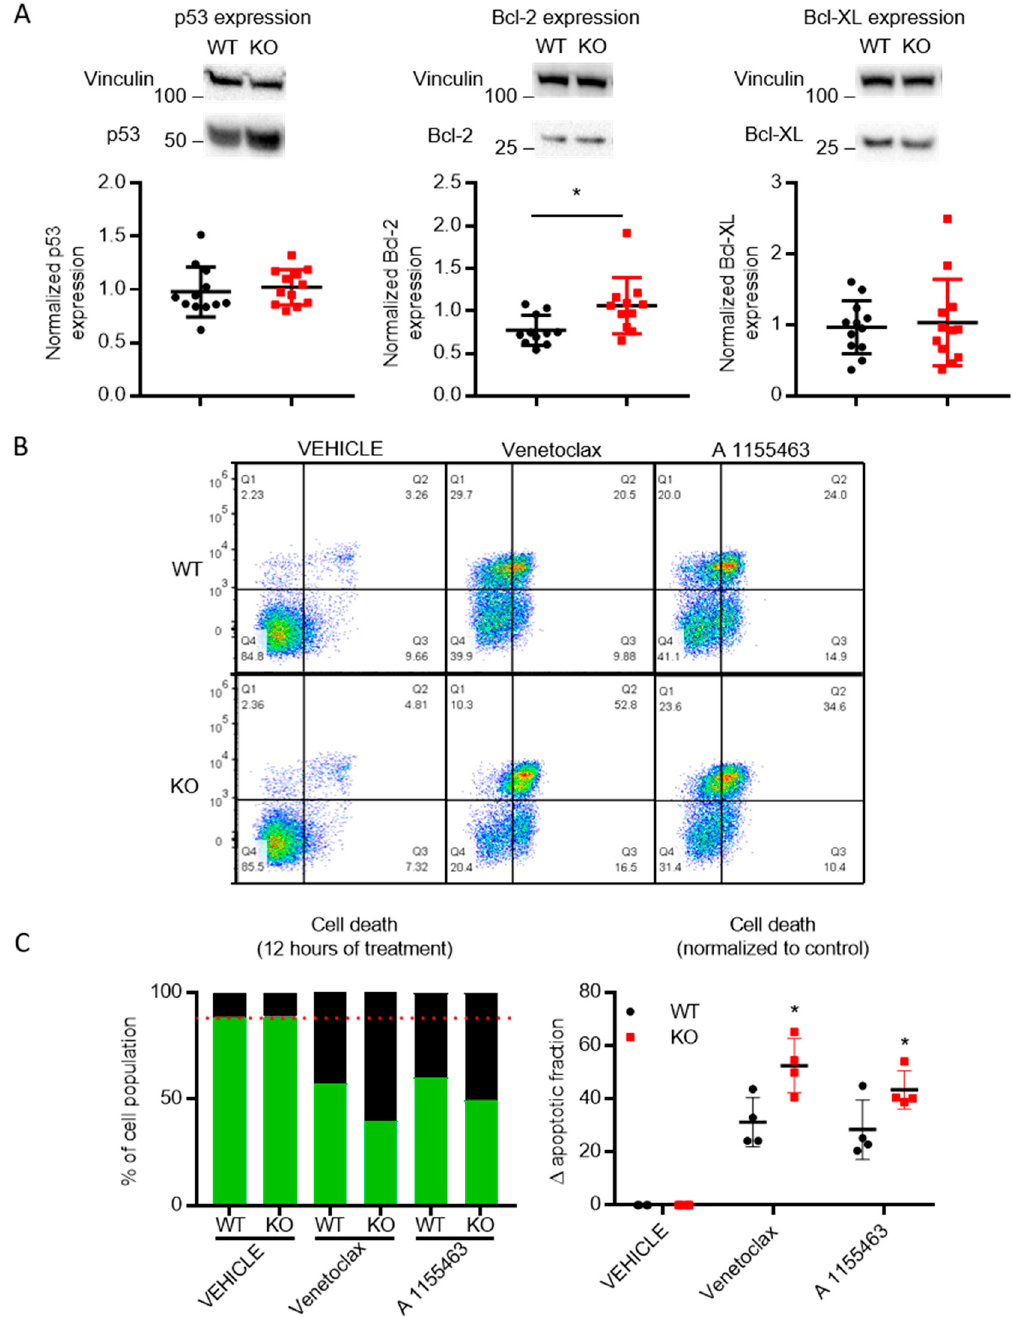
Figure 7. TMBIM5-KO cells display increased cell death sensitivity toward Venetoclax and A 1155463 than WT cells. ( A ) Immunoblot analysis (top) and quantification (bottom) of p53, Bcl-2 and Bcl-XL-protein levels. TMBIM5-KO cells have slightly higher Bcl-2-protein levels while similar levels were detected for p53 and Bcl-XL. * p < 0.05 analyzed with t -test. ( B ) Representative dot plots from flow cytometry analysis detecting apoptosis in Annexin V-FITC / 7-AAD-stained cells for vehicle-, venetoclax-, and A 1155463-treated conditions. ( C ) Cells death was assessed via flow cytometry after 12 h of treatment with venetoclax or A 1155463. The ∆ apoptotic fraction was calculated by subtracting the cell death obtained with vehicle-treated conditions. TMBIM5-KO cells displayed higher sensitivity to Bcl-2 and Bcl-XL inhibitors than WT cells. Graphs showing mean ± SD. * p < 0.0001 Analyzed with one-way